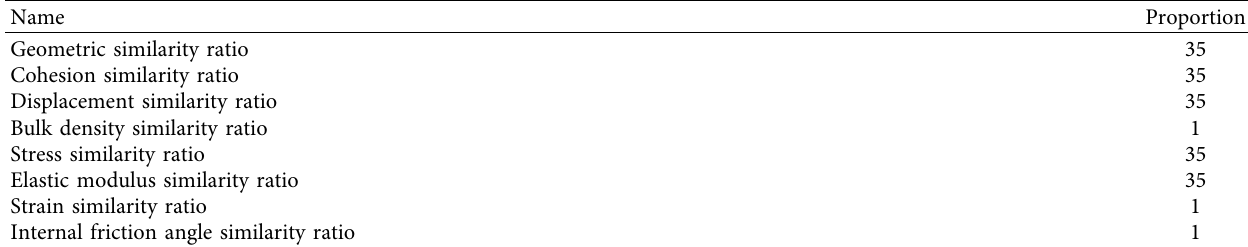
Table 4: Te similarity ratio of each parameter of the model experiment.